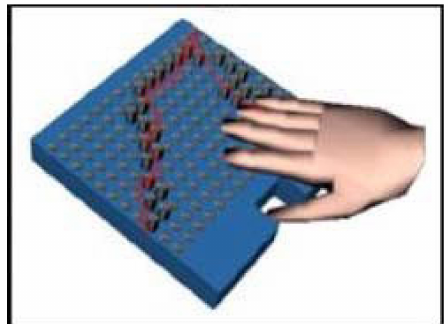
Figure 4. Intelligent glasses and its tactile display [45]. Tyflos uses a 4 × 4 array of vibrators on an elastic vest on the user’s abdomen with varying vibration frequencies controlled by a microprocessor and portable computer